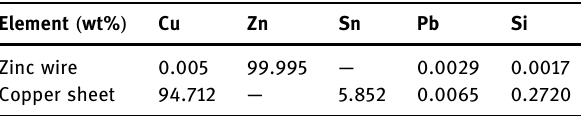
Table 1: Chemical composition of supplied main alloying elements